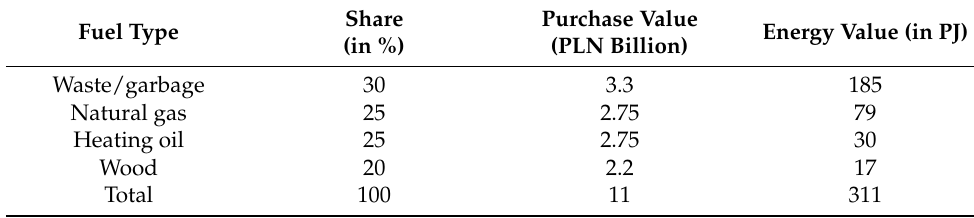
Figure 3. Scenario 5—energy value of the assumed mix of alternative fuels. Source: own study. Table 2. Estimation of the energy value for scenario 5.